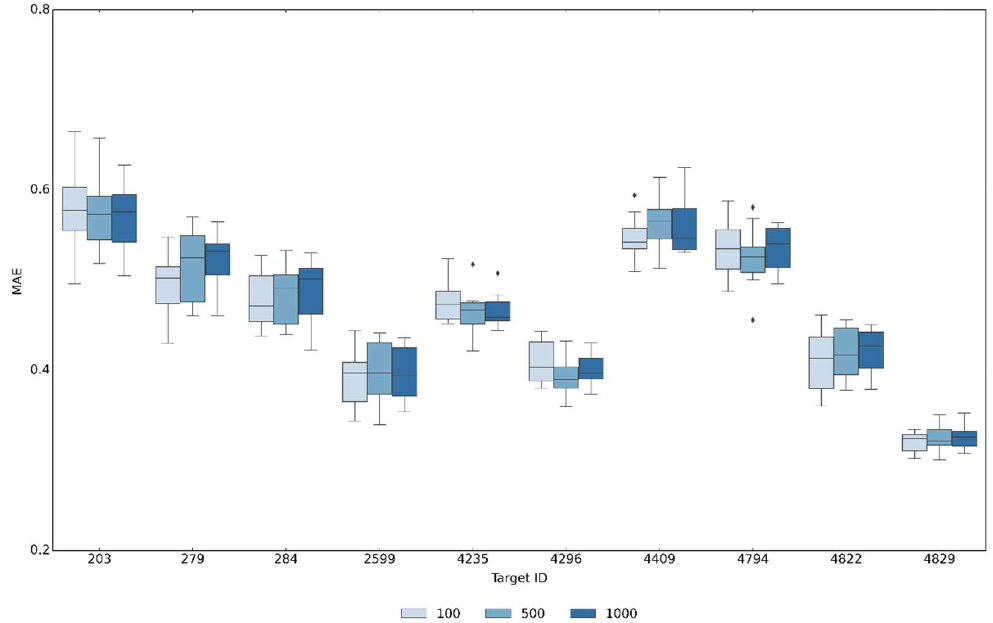
Figure 2. Prediction accuracy for SPSF with differently sized potency modules. Boxplots report mean absolute error (MAE) values of SPFP‒CVAE models using alternative SPFP versions with potency modules comprising 100, 500, or 1000 bits evaluated across all activity classes according to Table 1. In boxplots, the upper and lower whiskers indicate maximum and minimum values, the boundaries of the box represent the upper and lower quartiles, values classified as statistical outliers are shown as diamonds, and the median value is indicated by a horizontal line.